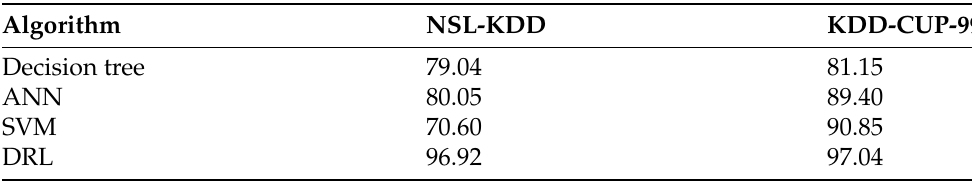
Table 6. DRL comparison with other machine learning